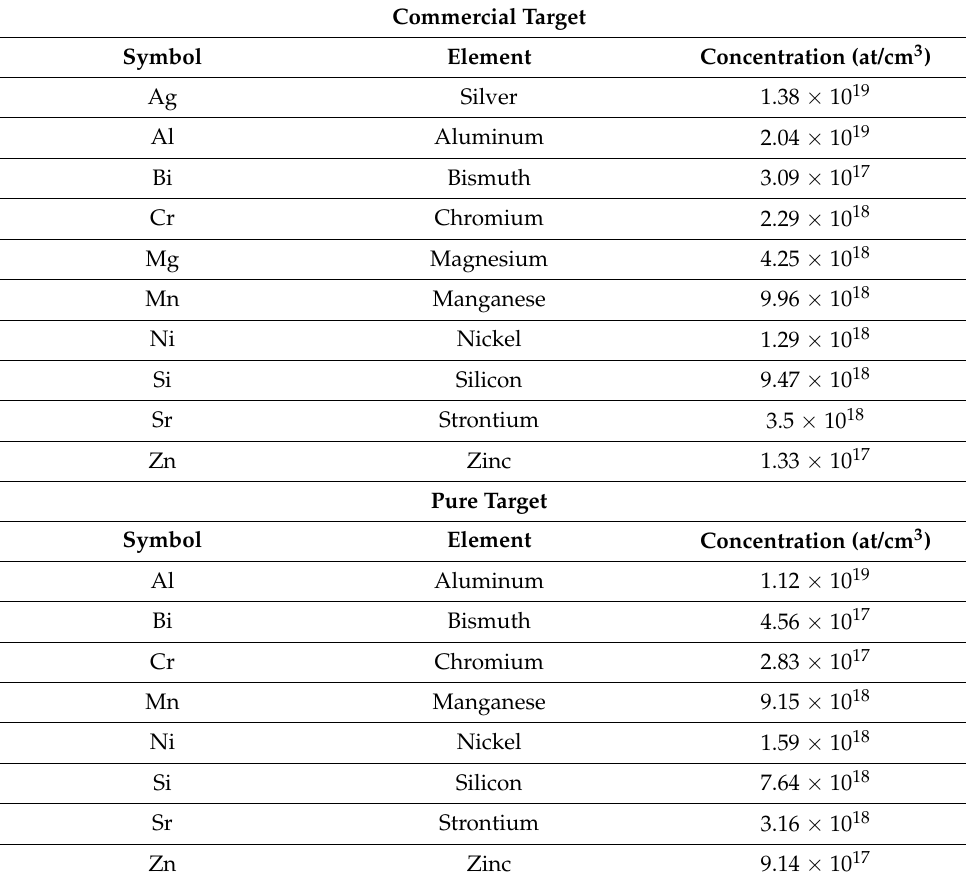
Table 4. Concentration of elements detected in the commercial and pure targets using ICP-MS